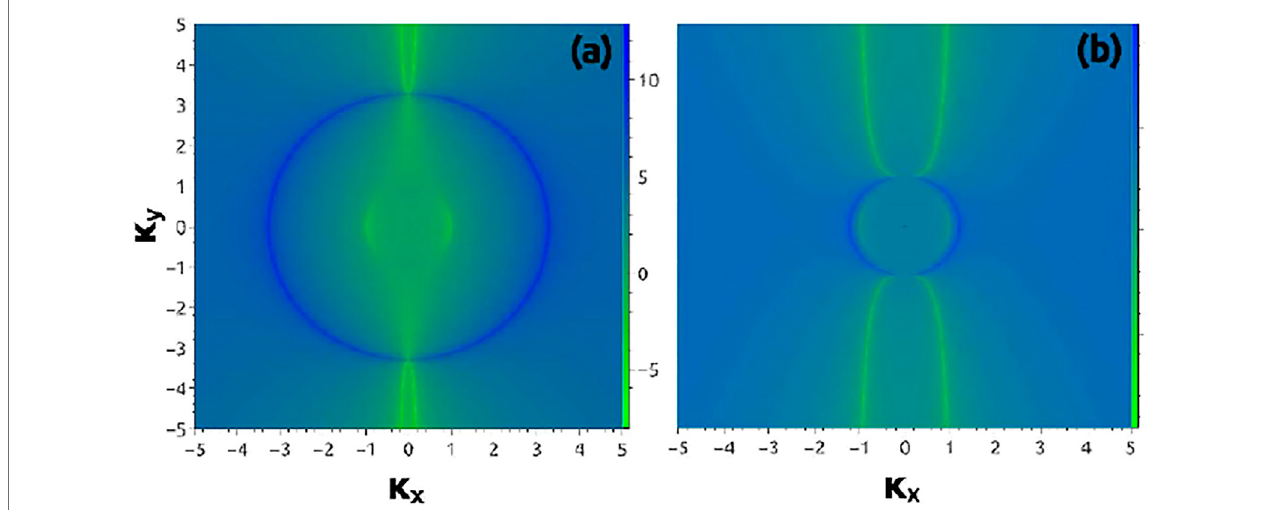
FIGURE12| [41]Twodimensionalintensitygraphofthelogarithmofdiamondtransientef fi cacyfactorasafunctionofthenormalizedtothelaserwavelengthLIPSS wave vector components. In (A) ω p (cid:2) 1.5 ω L and (B) ω p (cid:2) 1.5 ω L .